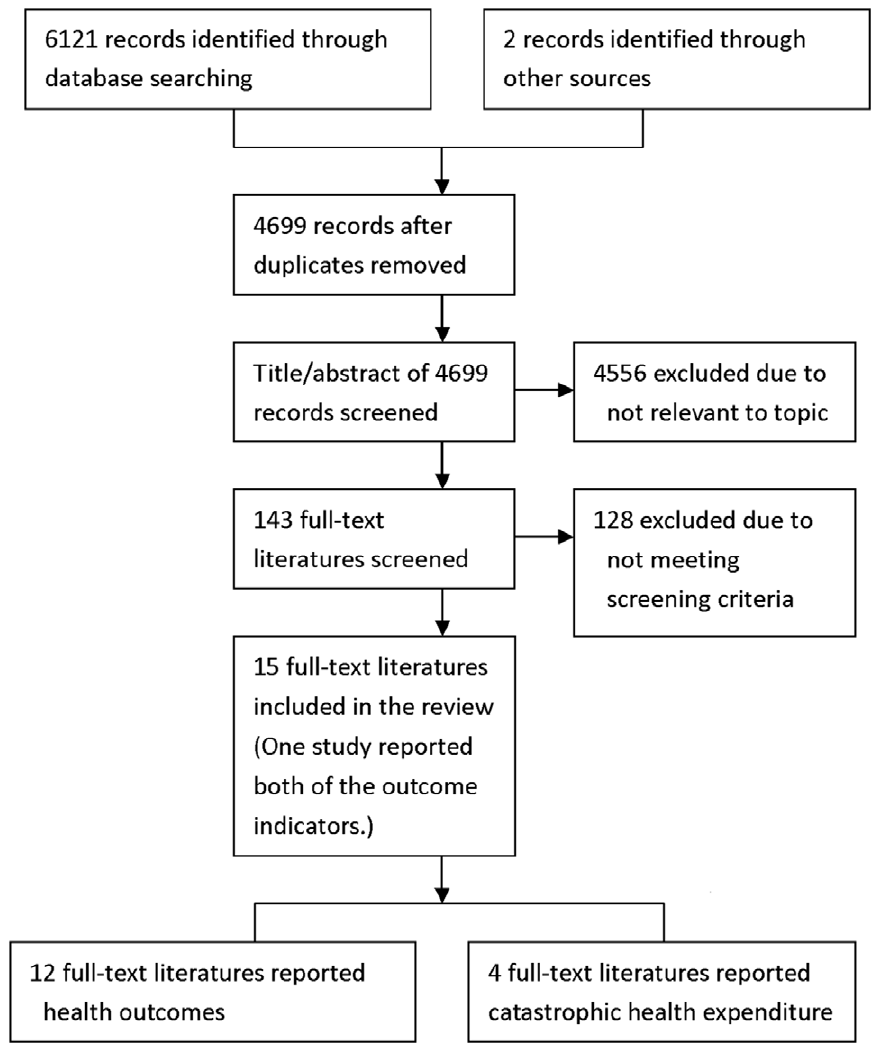
Figure 1. Flow diagram for selection of studies.